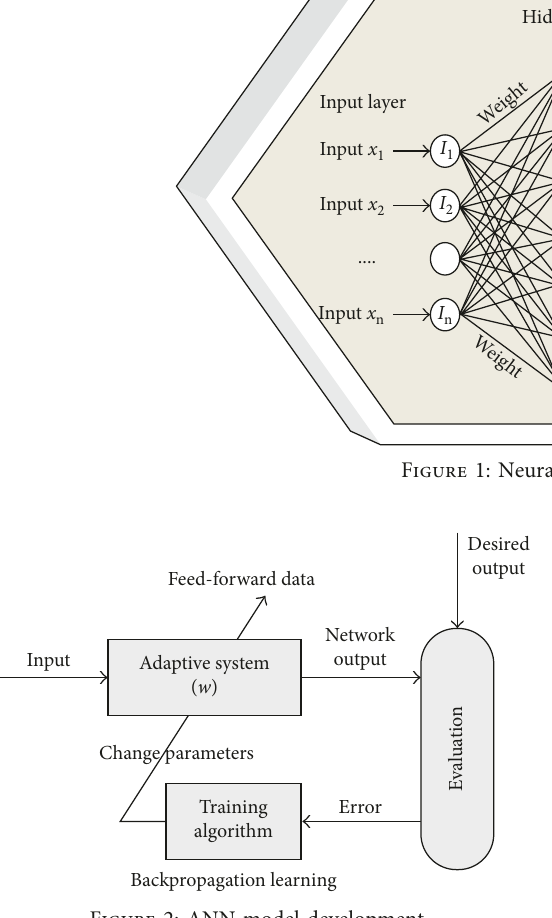
Figure 2: ANN model